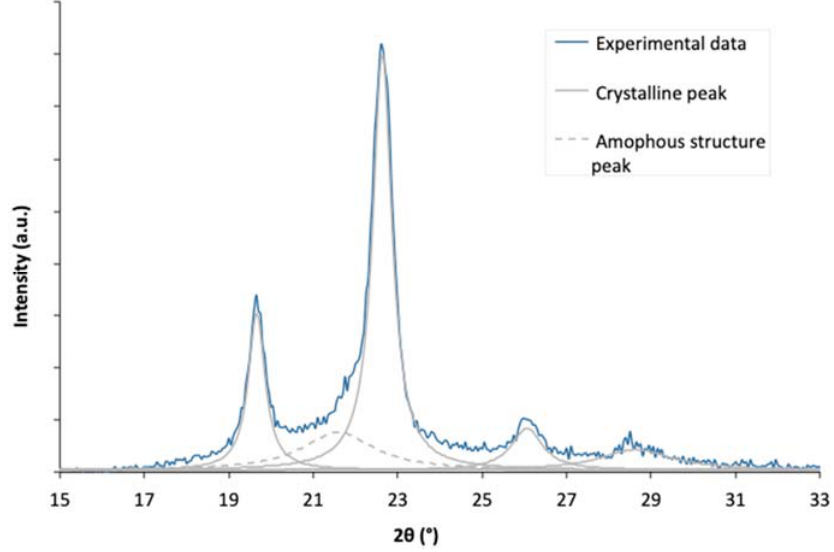
Figure 9. XRD spectrum of PBS sample and identification of the characteristic peaks.